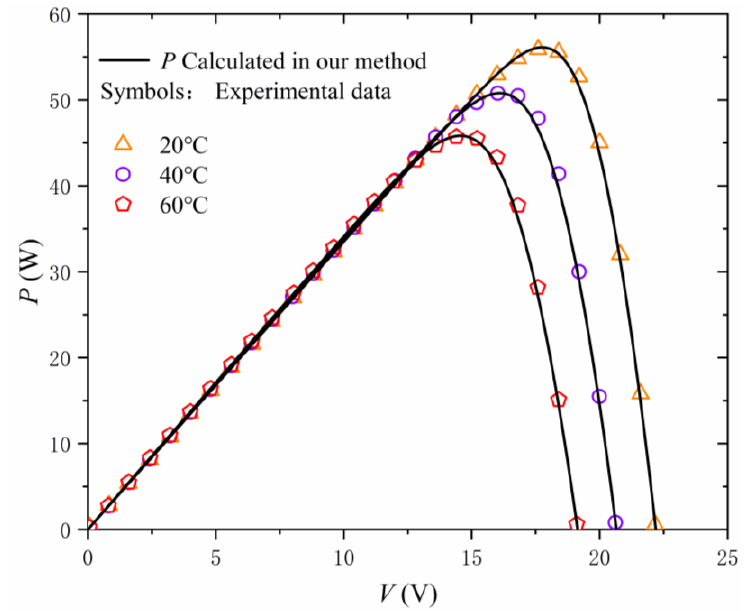
Figure 10. I-V characteristics measured and calculated, respectively, for the thin-film SM55 PV panel in different temperature conditions.